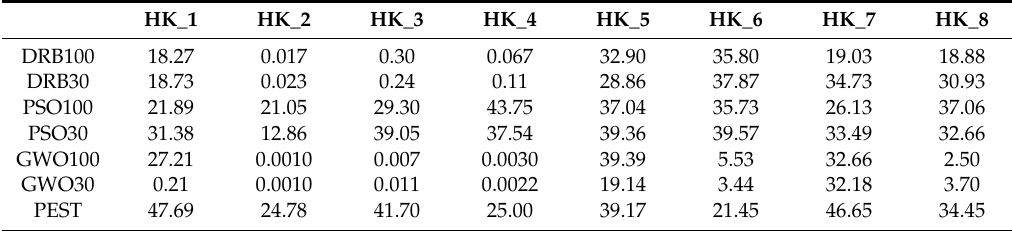
Table 4. Standard deviation of 15 runs of each HK zone by optimizer/agent number pair.